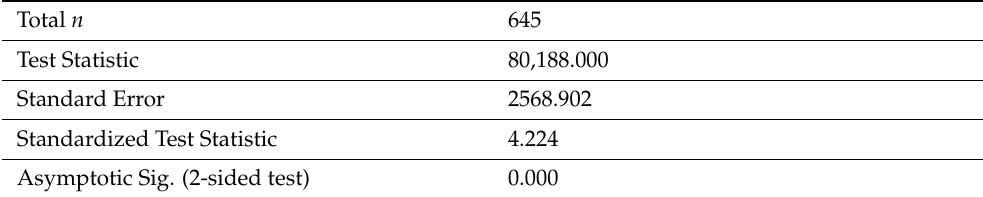
Table 7. HDIm independent-samples Jonckheere–Terpstra test for ordered alternatives summary.